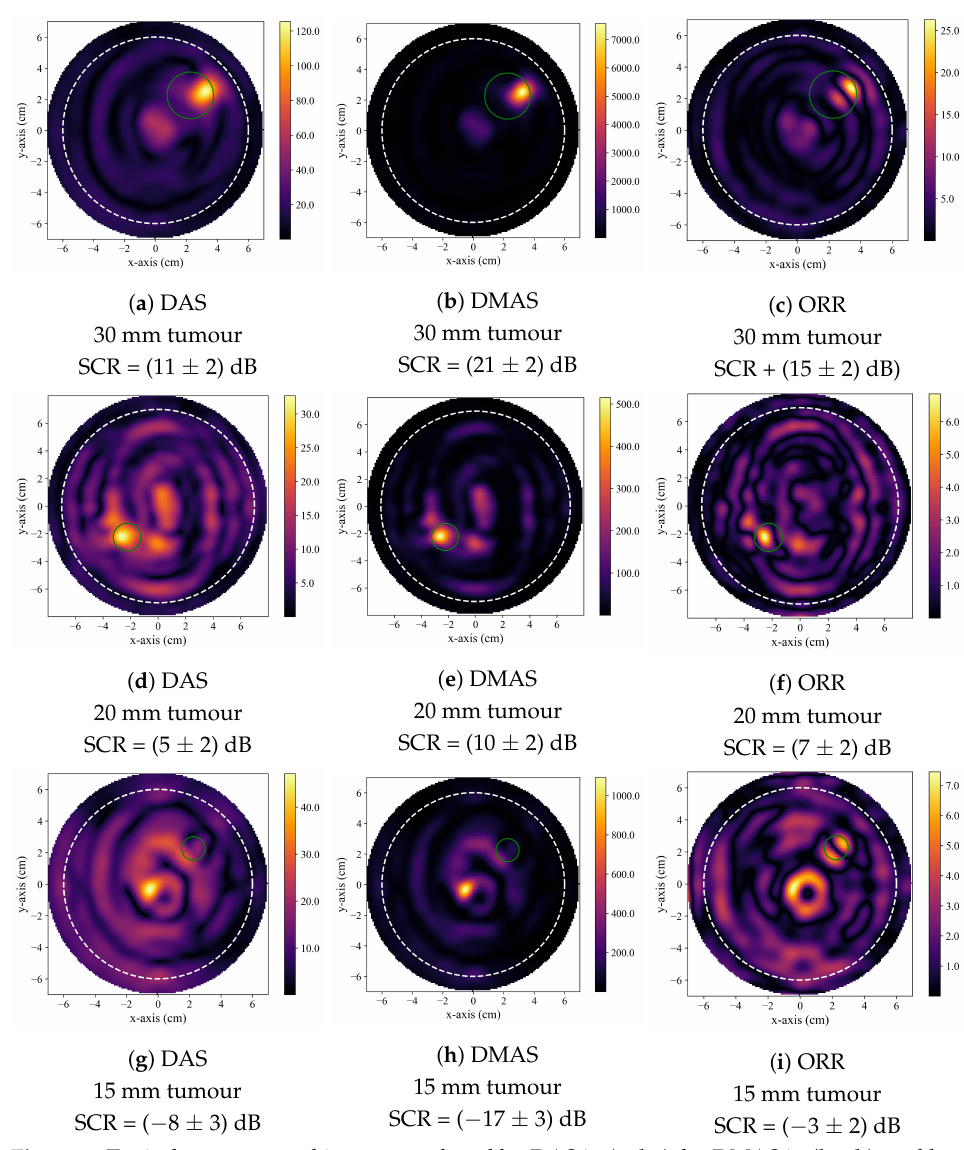
Figure 2. Typical reconstructed images produced by DAS in ( a , d , g ), by DMAS in ( b , e , h ), and by the ORR in ( c , f , i ). The first row displays reconstructions of a phantom containing a 30 mm tumour, the second of a phantom containing a 20 mm tumour, and the third of a phantom containing a 15 mm tumour. In all reconstructions, the dashed white circle indicates the approximate outer boundary of the breast phantom, and the solid green circle indicates the known tumour